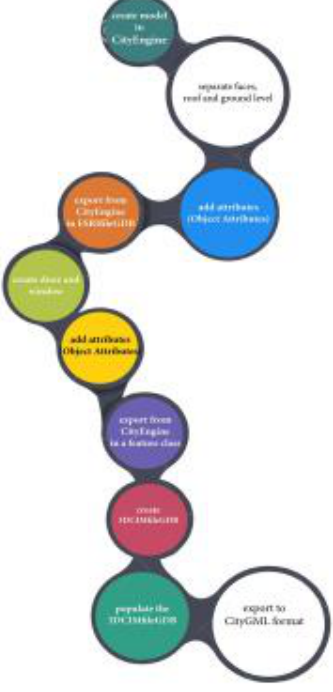
Figure 2: Workflow of the 2nd